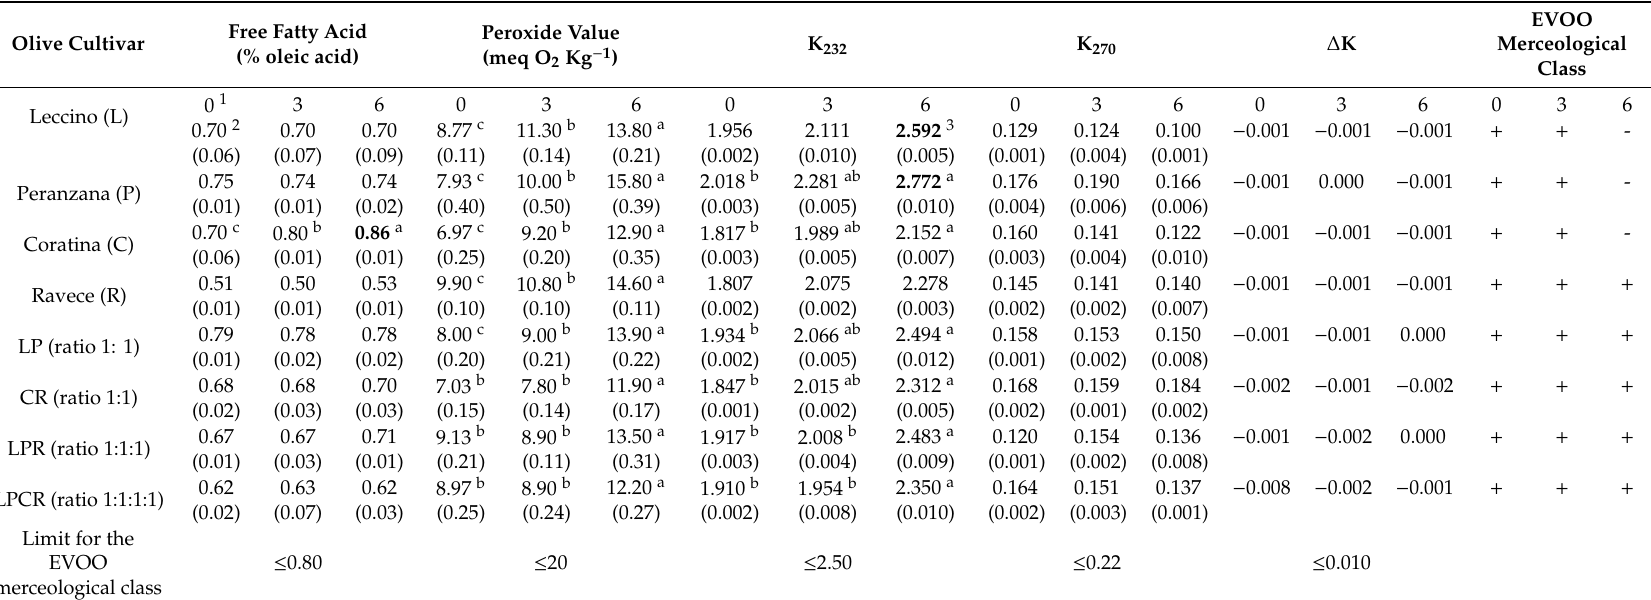
Table 6. Analytical indices of monovarietal and blended extra virgin olive oils (EVOOs) evaluated during six months of storage. Olive